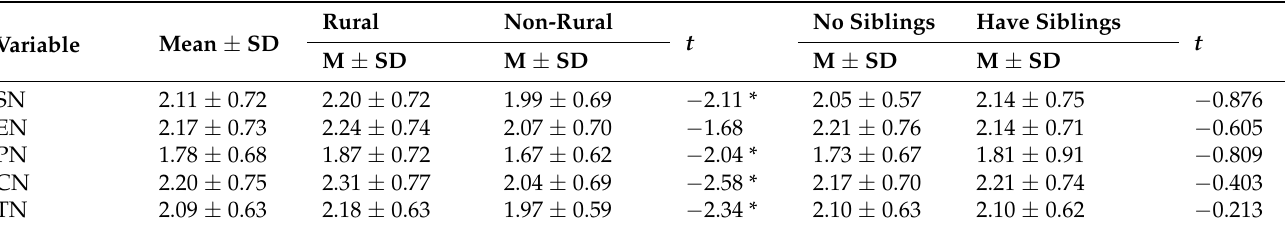
Table 6. The descriptive statistics and t -test results of child neglect among juvenile